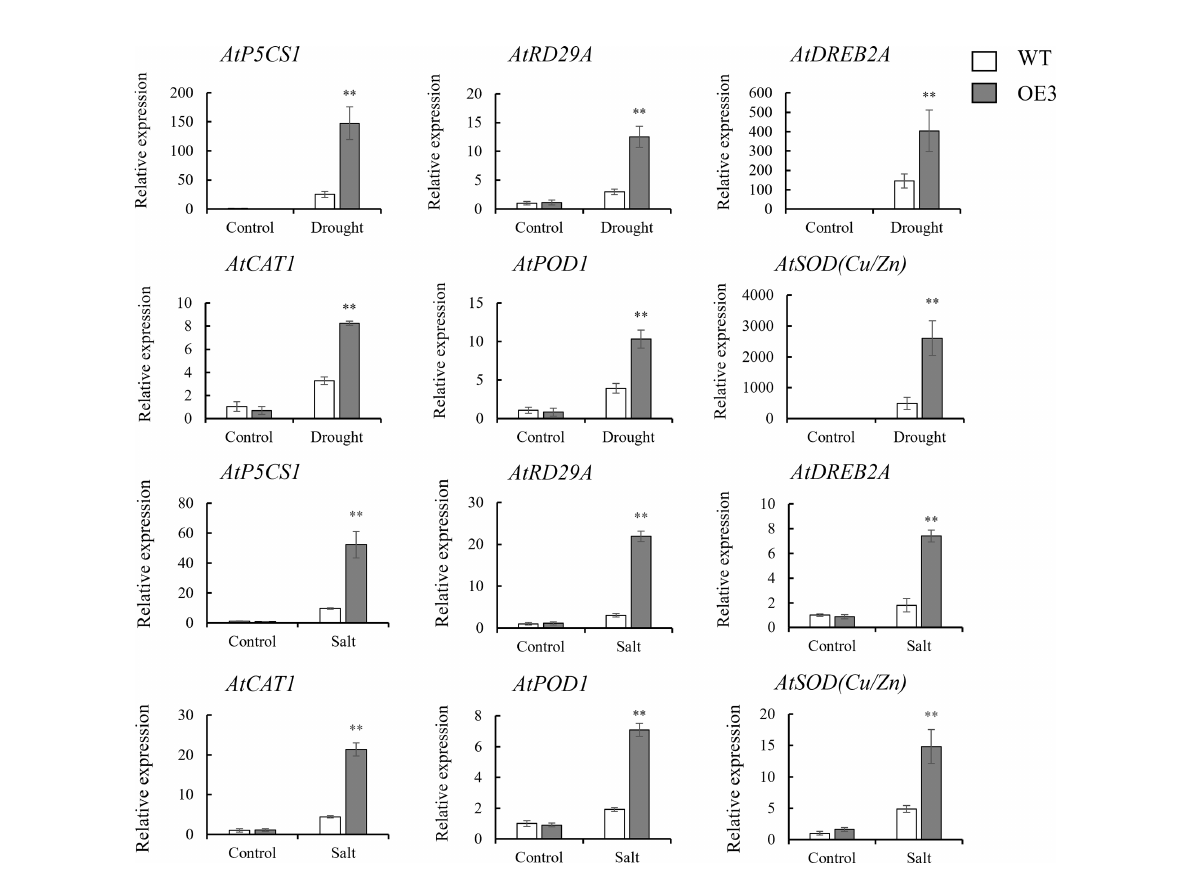
FIGURE 8 The expression levels of stress-related genes in the OE3 line and WT under stresses. stress-related genes — AtP5CS1 , AtRD29A and AtDREB2A ; antioxidant-related genes — AtCAT1 , AtPOD1 and AtSOD ( Cu/Zn ). Stresses include drought stress and salt stress. Standard deviations are indicated by error bars (mean ± SD and n = 3). Student ’ s t-test was used to calculate signi fi cance: ** indicates p >